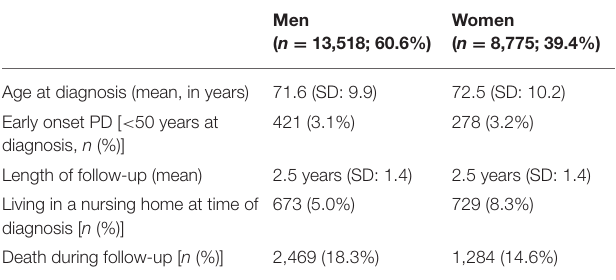
TABLE 1 | General characteristics of the population ( n =